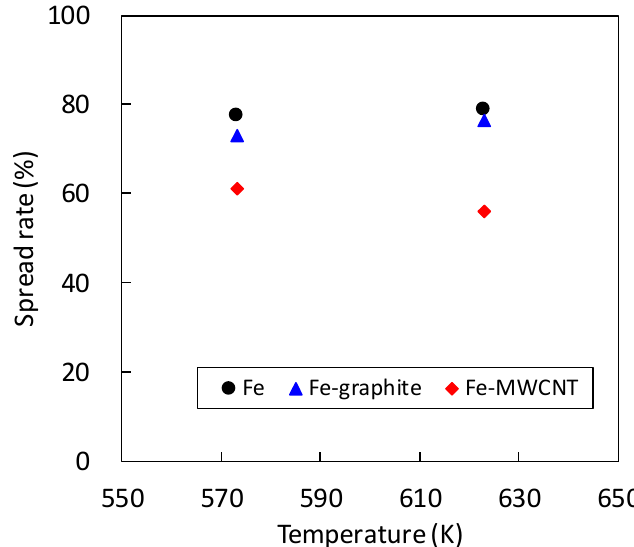
Figure 8. Temperature dependence on spread rate for several plating layers.